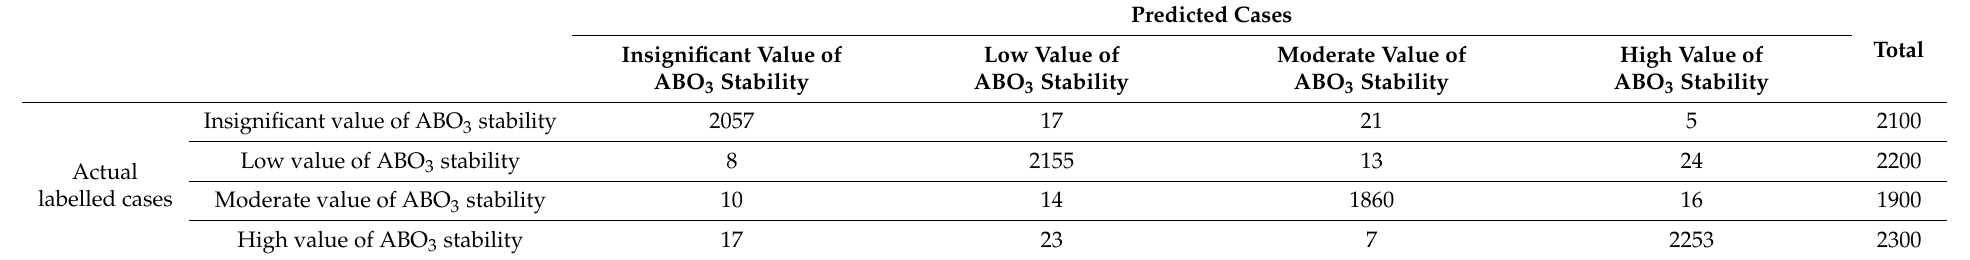
Table 9. Confusion matrices for value of ABO 3 stability with transfer